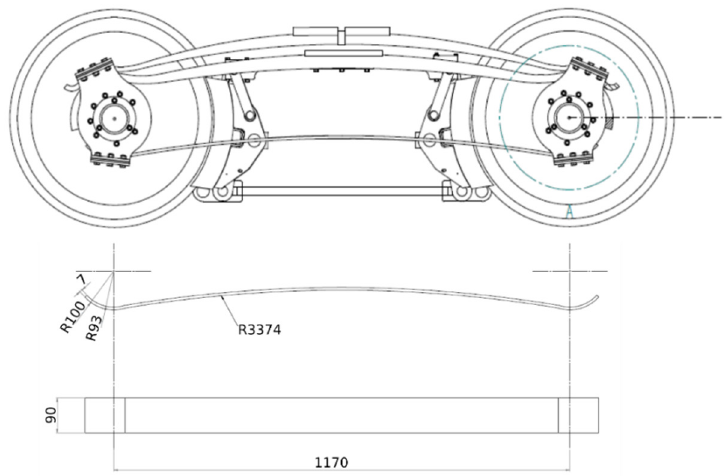
Figure 3. Leaf spring for a bogie of a narrow-gauge railway.